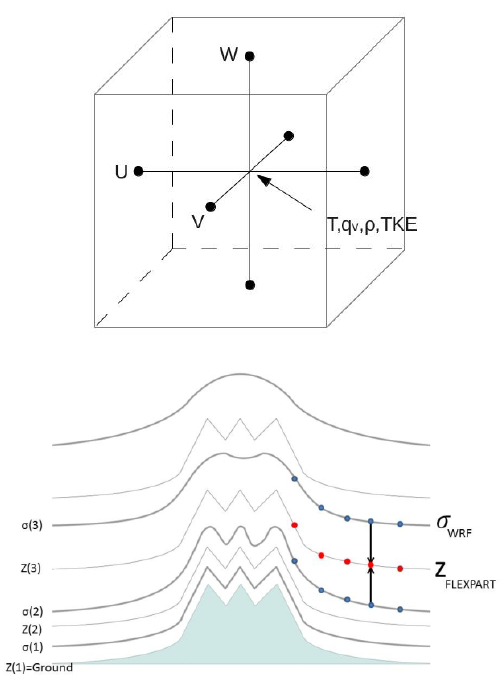
Fig. 2. Top: Arakawa C grid representing the staggering of the wind field ( U,V,W ) and T , q v , TKE at the center of the grid. Bottom: terrain-following coordinates used in WRF ( σ ) and FLEXPART ( z